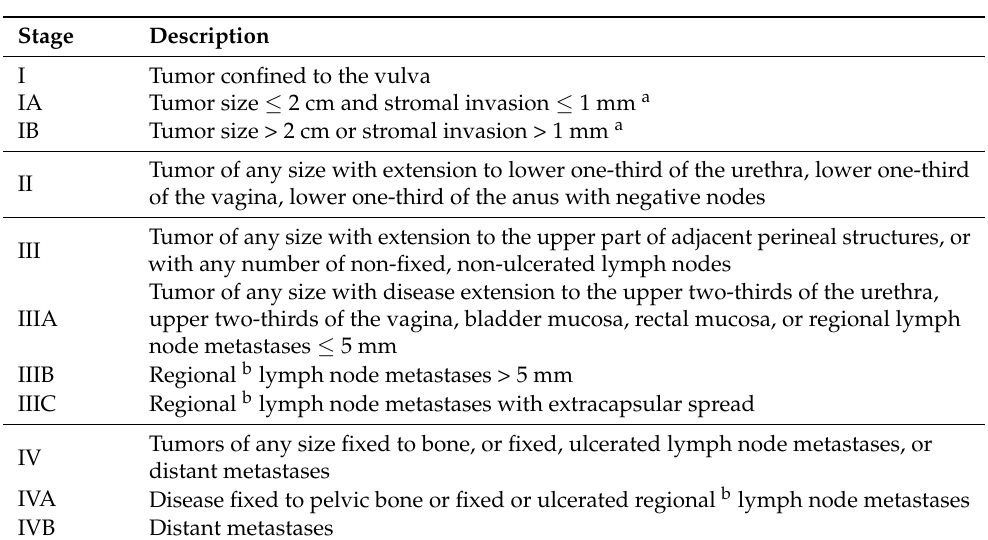
Table 2. FIGO staging of vulvar carcinoma